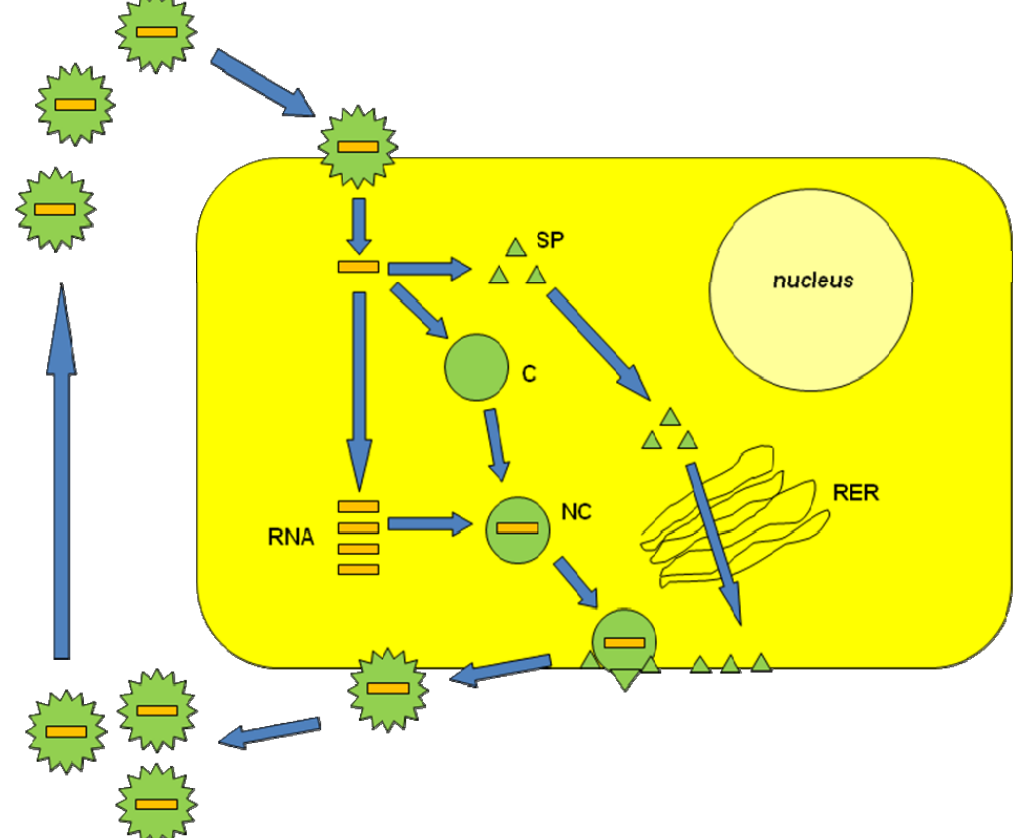
Figure 1. Alphavirus life-cycle. Alphavirus particles enter host cells through fusion with the plasma membrane and RNA is released into the cytoplasm. Capsid (C) and spike proteins (SP) are expressed. New copies of RNA form nucleocapids (NC) with C and are transported to the plasma membrane. Simultaneously, the SPs travel through the rough endoplasmic reticulum (RER) before being assembled with NCs. Mature viral particles are released through